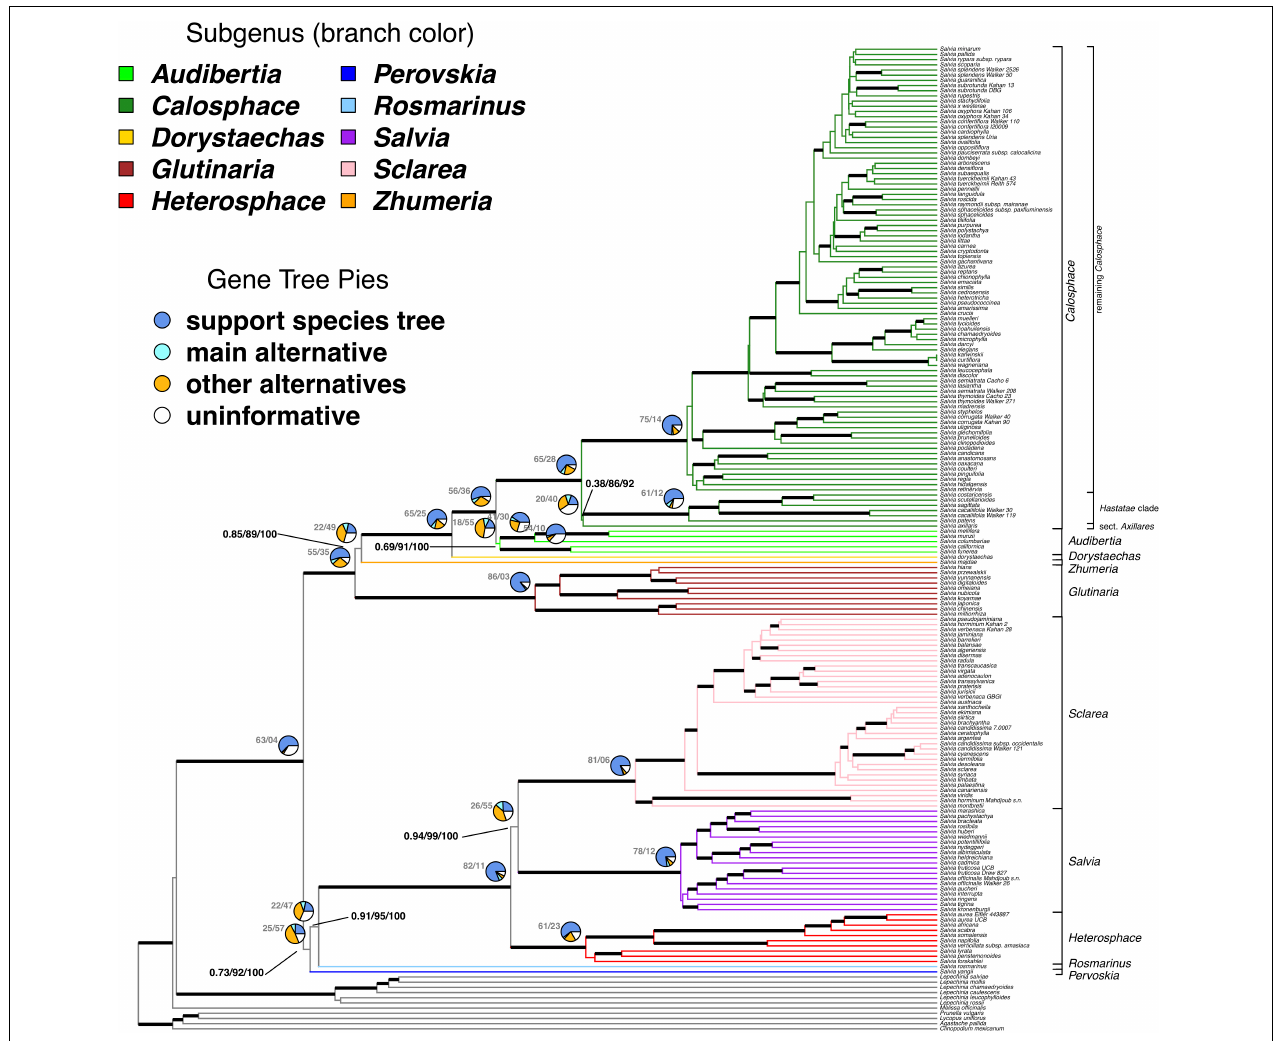
FIGURE 1 | The ASTRAL species tree of Salvia and outgroups. The ingroup branches are colored by subgenus and the subgenera are also labeled to the right. The major clades as discussed in the text are also indicated for subg. Calosphace . Thickened branches denote those with > 0.95 ASTRAL local posterior probability. Pies at major nodes summarize the percentage of various phylogenetic signals across 101 gene trees which can be rooted. The numbers at the left of the pies show the total number of gene trees in which the clade is found, followed by the total number of gene trees that conflict with that clade. The remainder of the gene trees, if any, do not provide information on that particular relationship. The numbers at selected, incompletely supported nodes show the ASTRAL local posterior probability followed by the ASTRAL bootstrap support and the bootstrap support from the concatenated maximum likelihood analysis, summarized on the ASTRAL species tree. For support across all branches, see Supplementary Figures S1, S2, S4 . For support on the best-scoring maximum likelihood tree, see Supplementary Figure S3